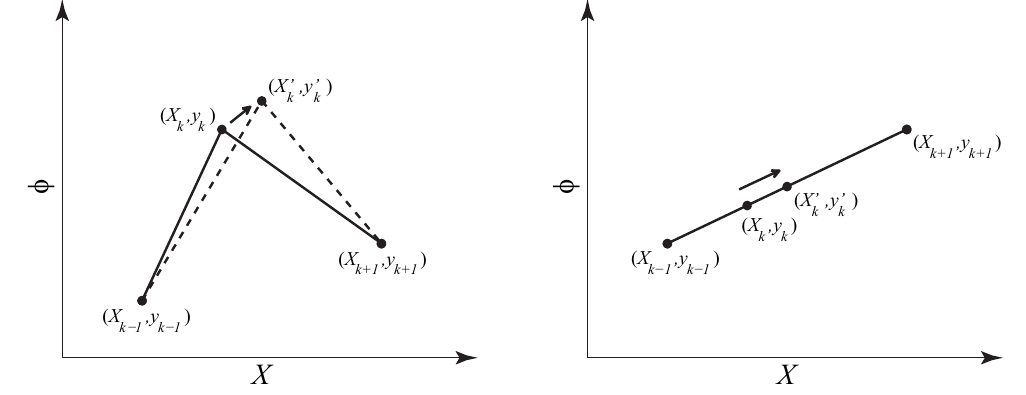
Figure 1. ( Left ) If γ k − 1 (cid:54) = γ k , then any change to the middle point changes the local shape of φ ( X , t ) . ( Right ) If γ k − 1 = γ k , then there are infinitely many possible positions for ( X k , y k ) that reproduce the local linear shape of φ ( X , t )